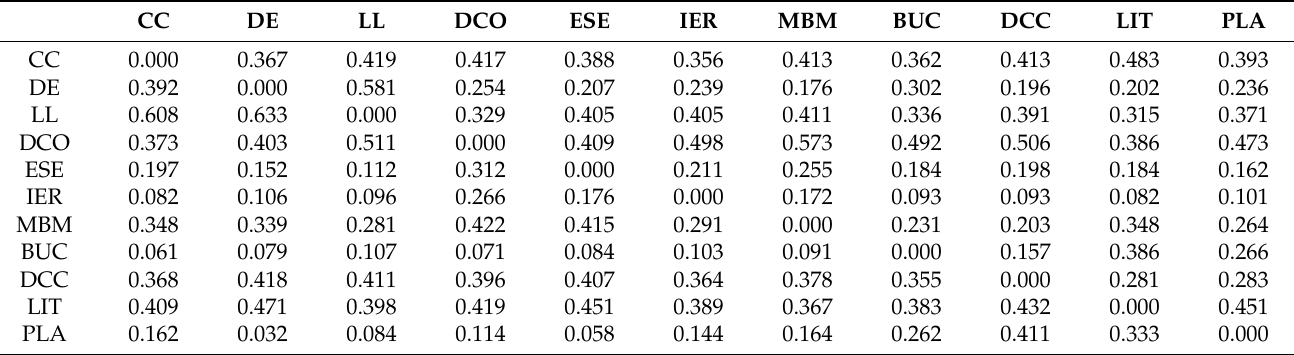
Table A1. Inner dependence matrix of 11 factors.